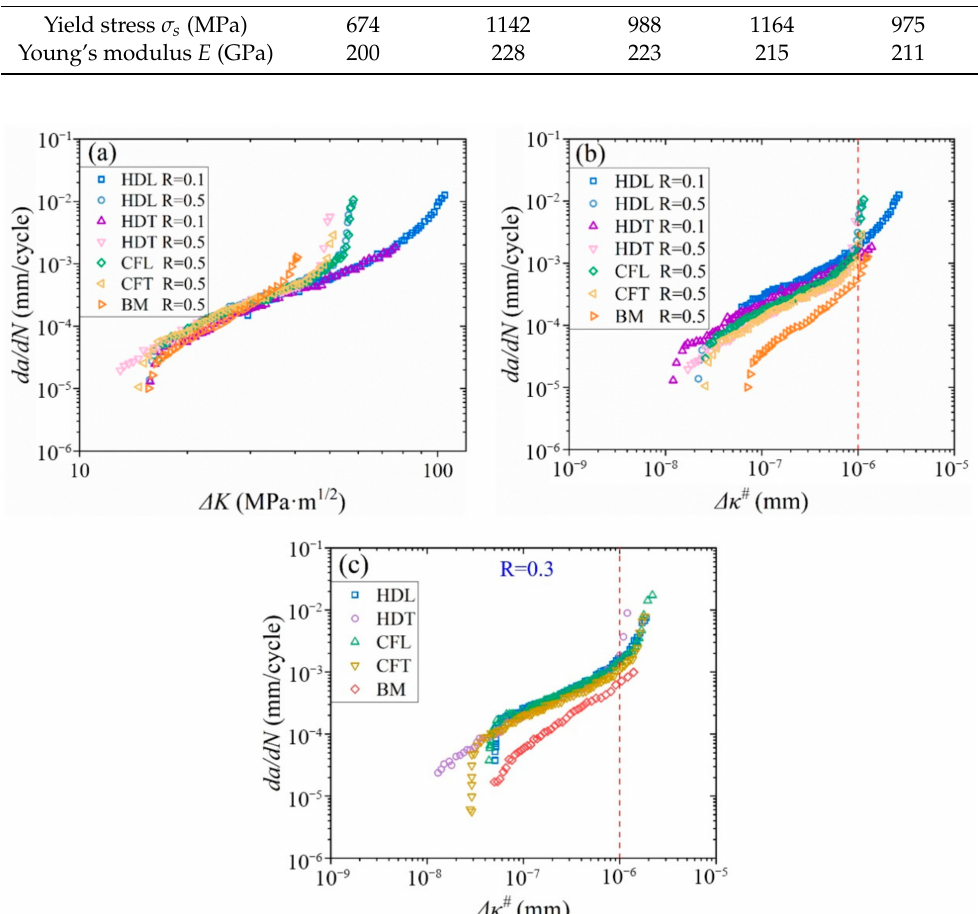
Figure 17. Fitting the FCG rate of different materials with ( a ) Paris model, ( b ) DFP model, ( c ) DFP model at R =